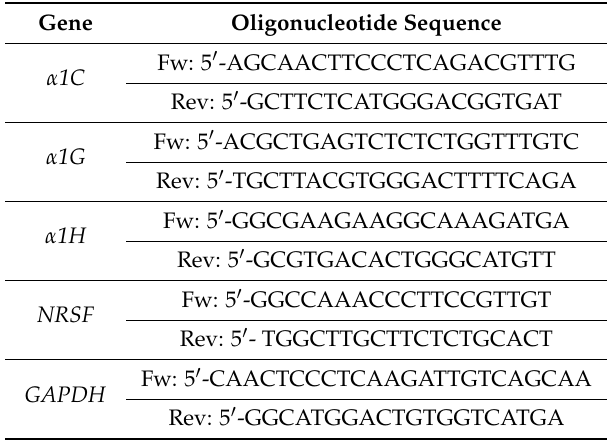
Table 1. Primers Used in Real-Time Quantitative